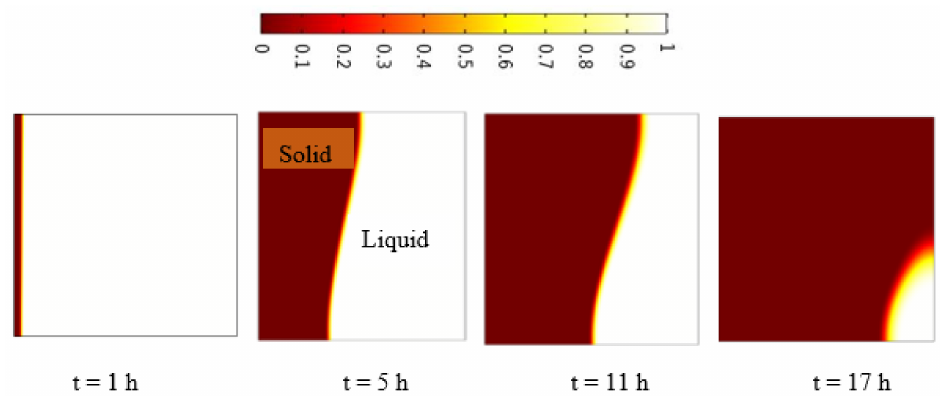
Figure 11. Temporal distribution of temperature during the discharging of the silicon domain.